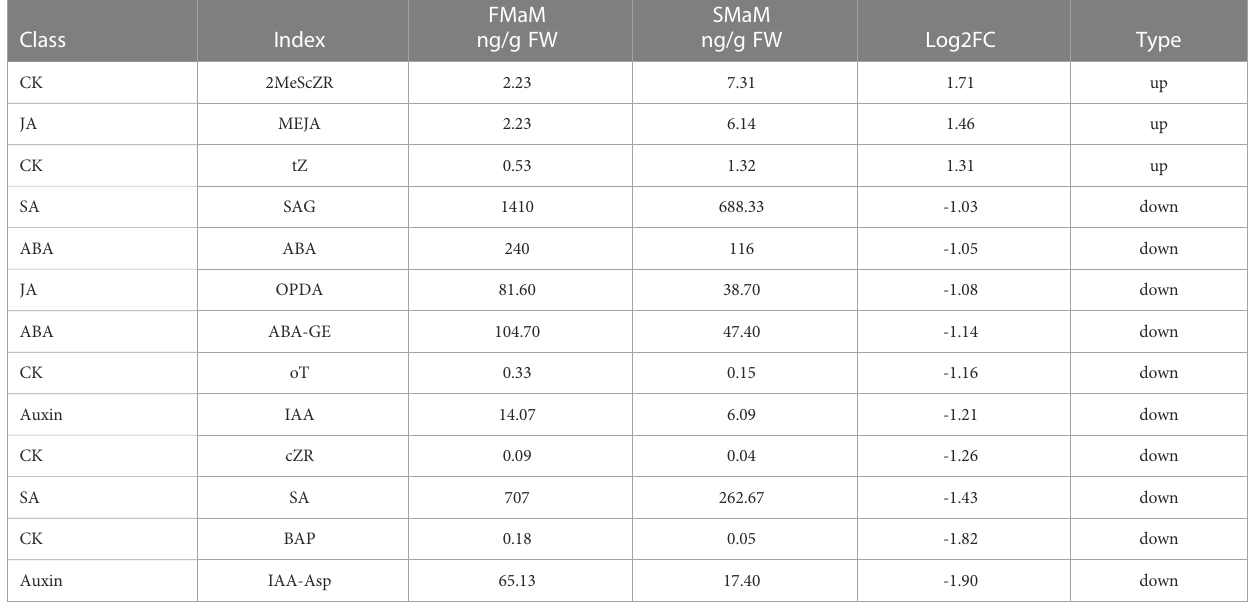
TABLE 2 Differences in hormone content in the comparison of